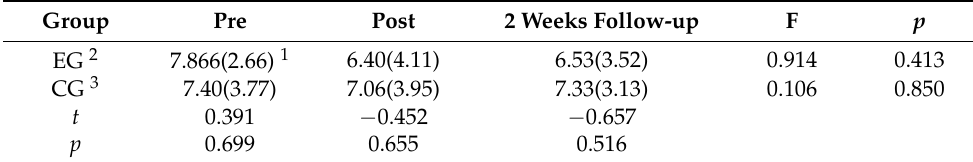
Table 4. Changes in Freezing of Gait Questionnaire (FOG-Q) by the period. Group